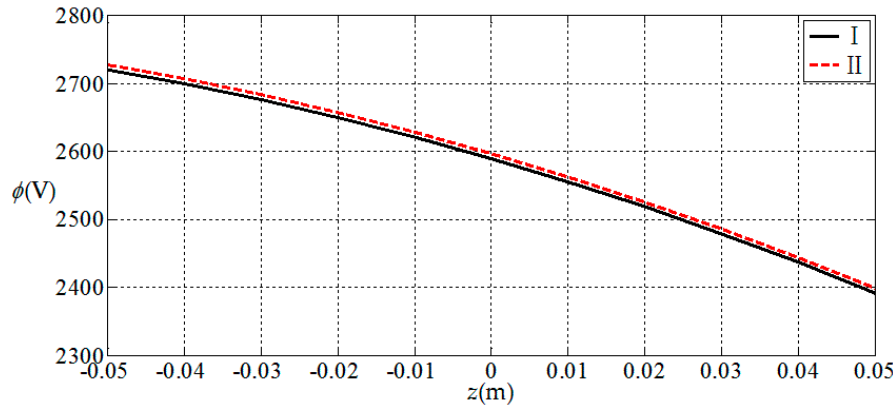
Figure 5. Variation of electric potential at the periphery of plate φ ( 1, z ) , where I denotes the solution presented in this study; II denotes the solution presented in [32].